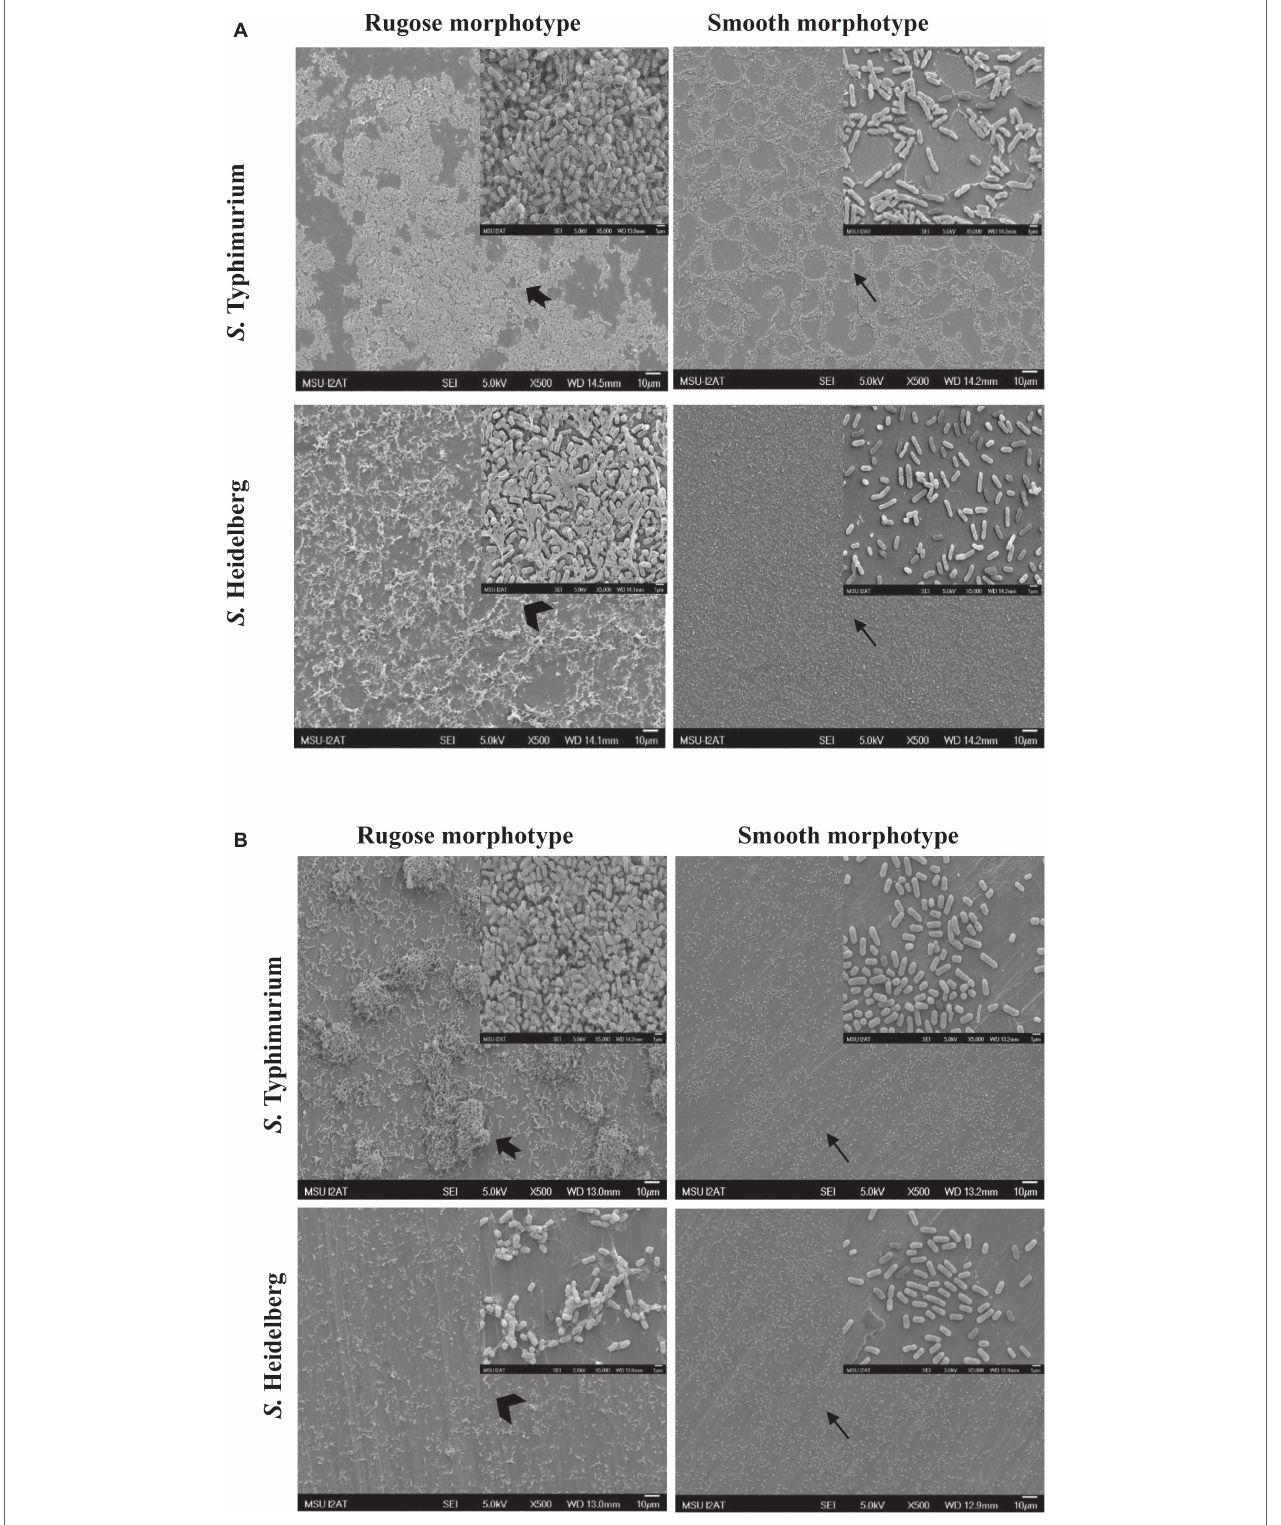
FIGURE 6 | Scanning electron micrographs of biofilms of S. Typhimurium and S. Heidelberg morphotypes on: (A) polystyrene surface, and (B) SS surface after 48 h at 25 ° C. Notched arrow indicate thick aggregates rugose biofilm of S. Typhimurium while arrow head indicate sparse aggregates of rugose biofilm of S. Heidelberg. Arrows indicate monolayer of smooth morphotype biofilm of both the